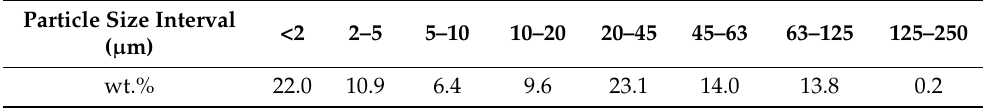
Table 2. Particle size distribution of crushed mussel